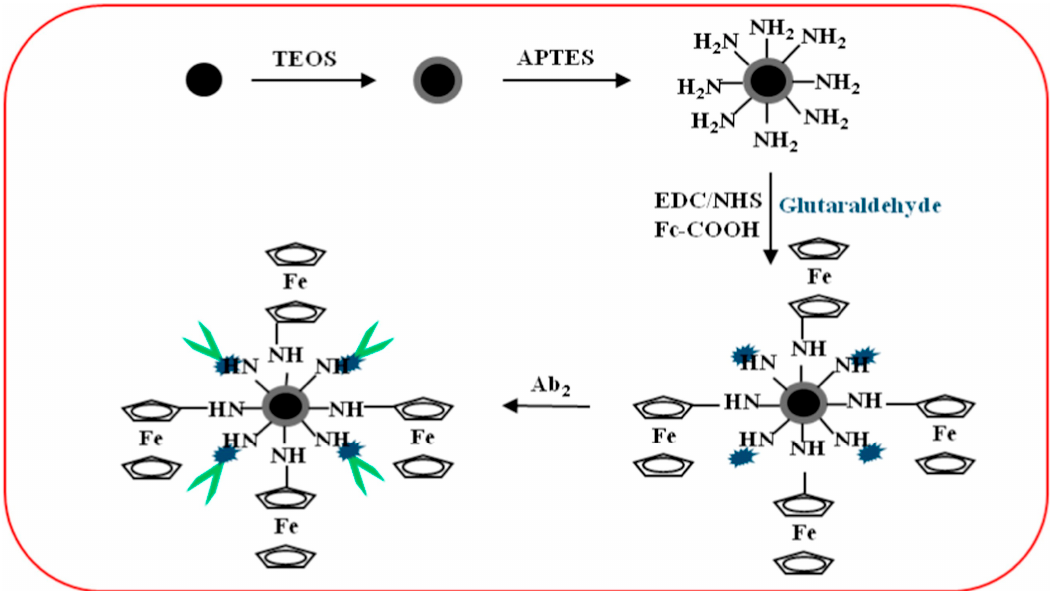
Figure 11. Preparation of Fe 3 O 4 @SiO 2 –Fc–Ab2/HRP bioconjugate. Reproduced with permission from [35].